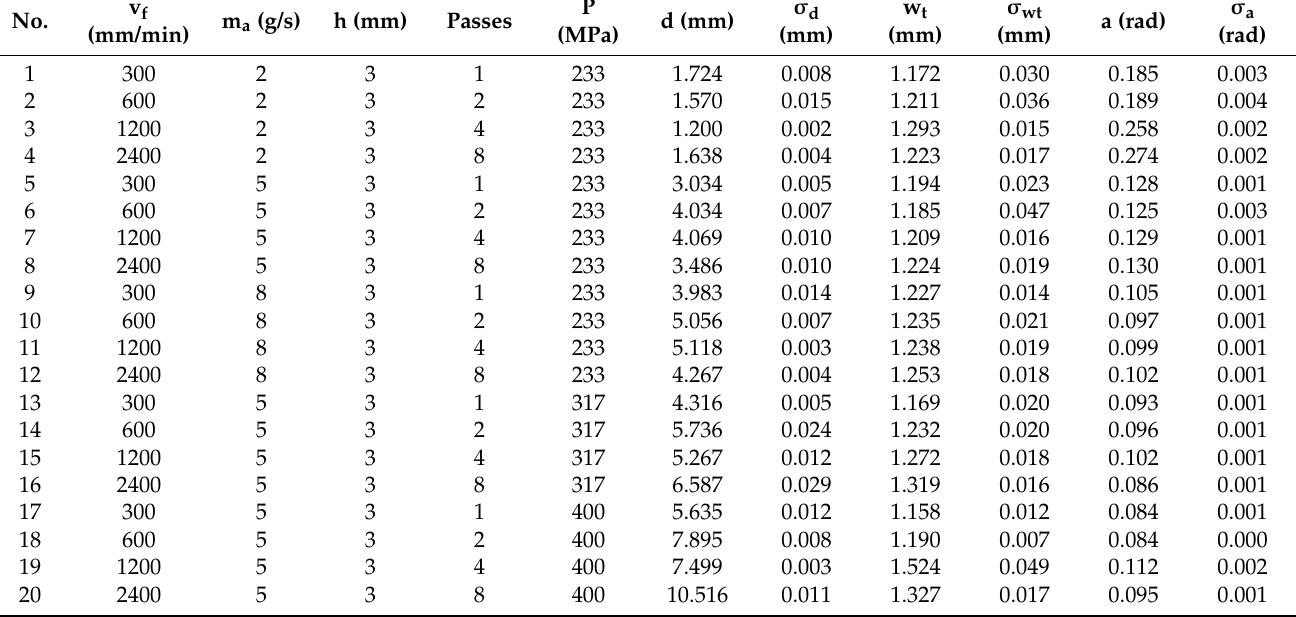
Table 3. Experimental conditions and